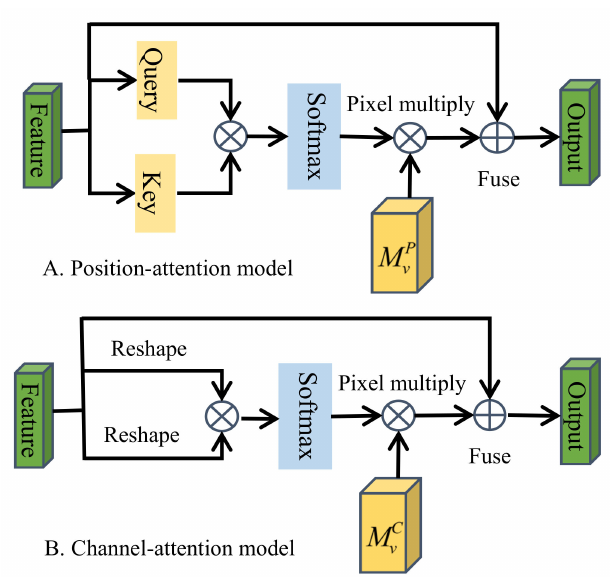
Figure 6. Balance the structure of the attention model. The details of the position-attention model and channel-attention model are illustrated in ( A ) and ( B